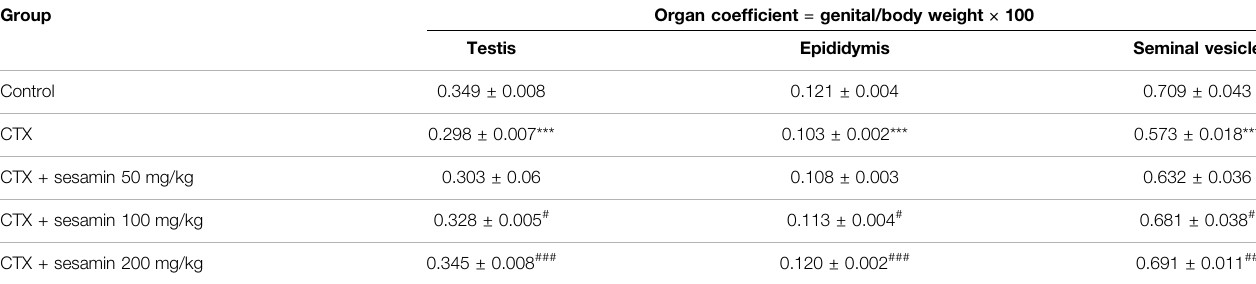
TABLE 1 | Effect of sesamin on the reproductive organ coef fi cient in mice with male spermatogenic dysfunction at 2 weeks (n (cid:2) 10, mean ± SEM). Group